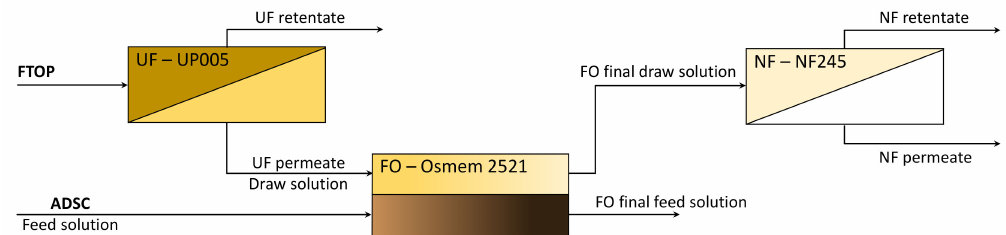
Figure 1. Schematic diagram of the integrated membrane process (FTOP: residual fermentation brine from table olive production; ADSC: anaerobically digested sludge